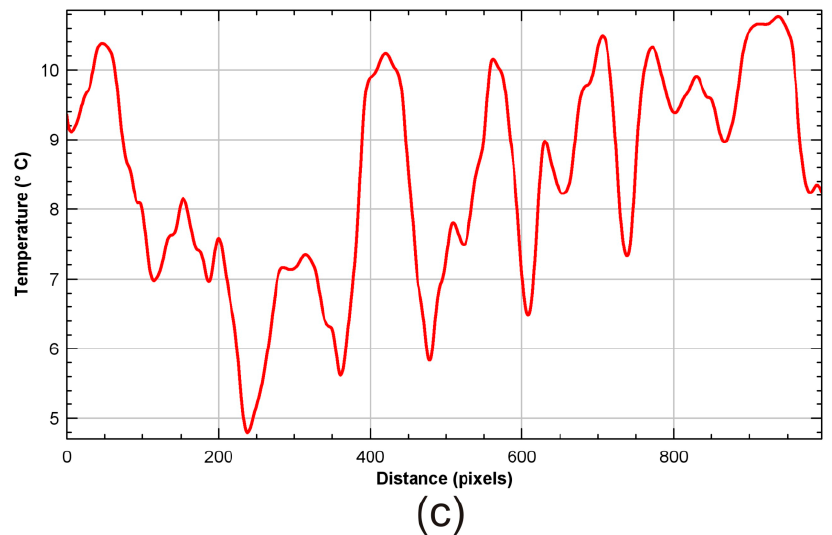
Figure 7. The Saracens Head Inn, Southwell, Nottinghamshire, U.K. ( a ) under normal lighting (daylight), as seen by the unaided eye; ( b ) in the thermal infrared with a custom LUT applied; and ( c ) a linear temperature plot across the centre of the target showing the signature of the buried timbers.